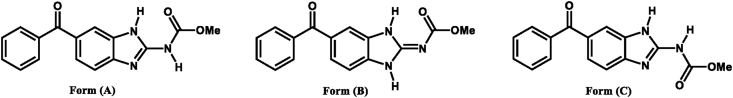
The 2D chemical structure of the three polymorphs of Mebendazole; reproduced from [19].